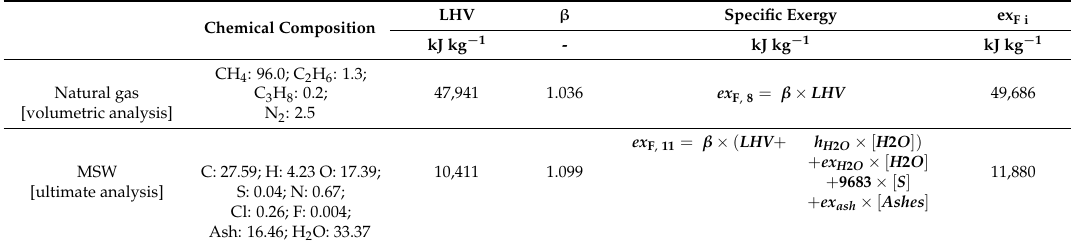
Table 2. Specific exergy of fuels employed in the